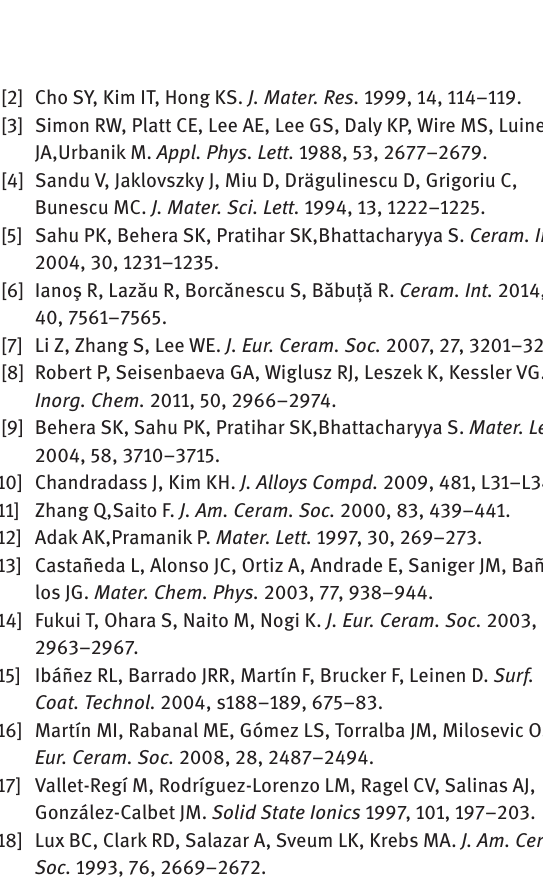
O and LaOCl precursors, LaAlO 2 3